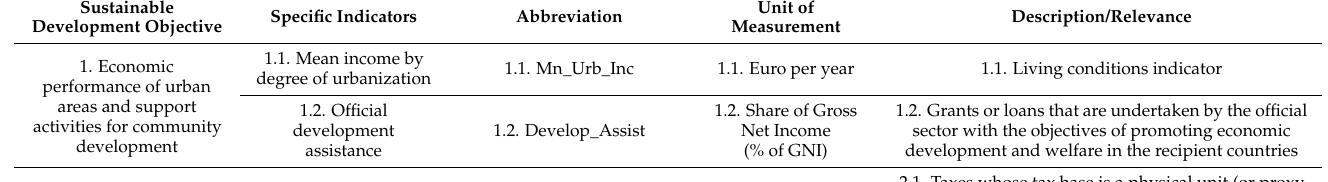
Table 1. The independent variables used for the panel data regression of the EU-28 Member